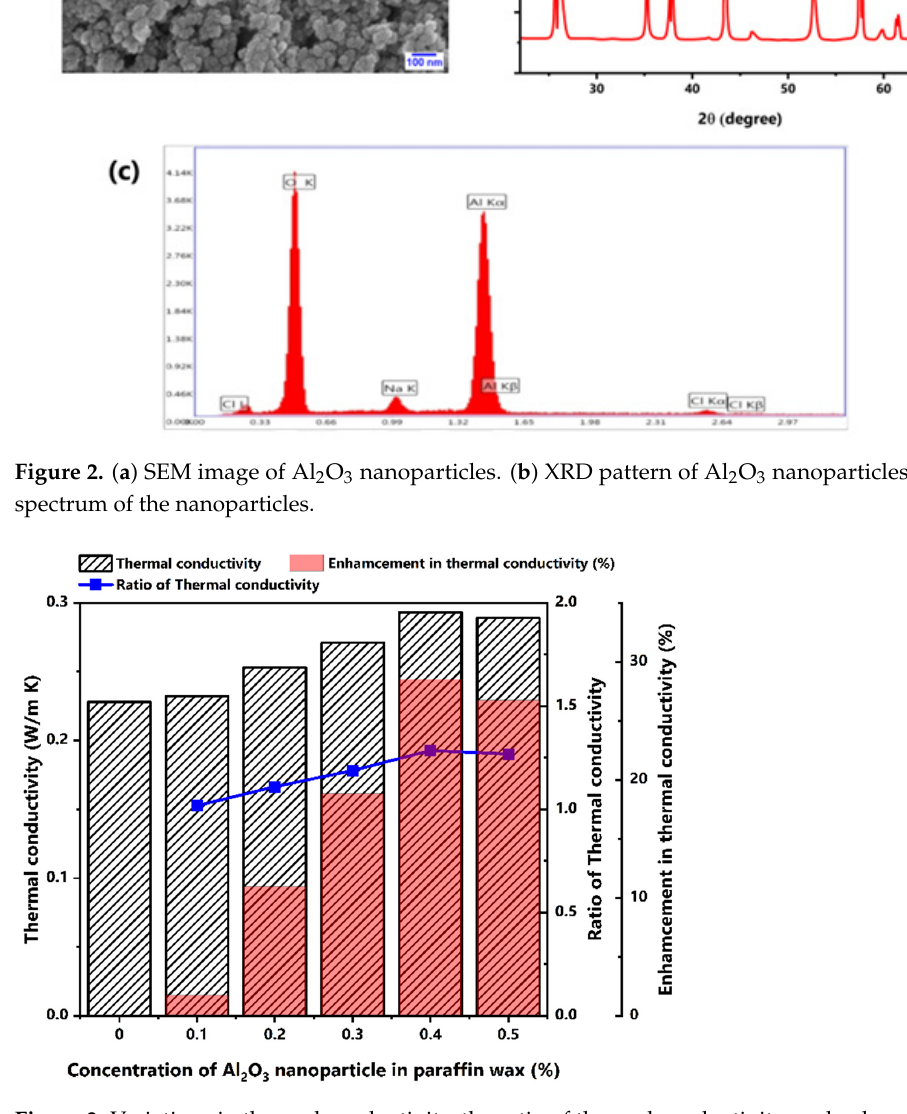
Figure 3. Variations in thermal conductivity, the ratio of thermal conductivity, and enhancement in thermal